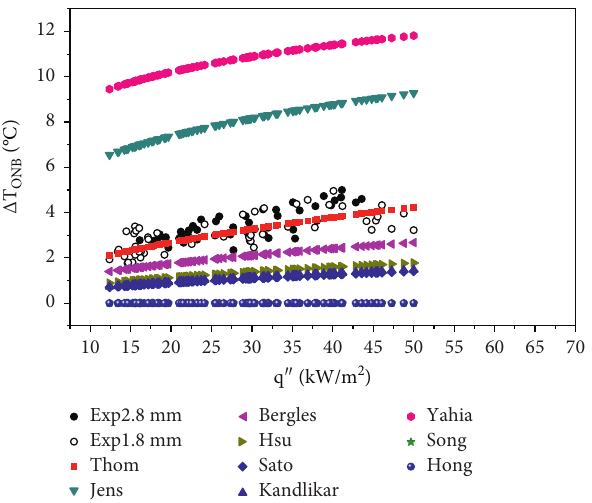
Figure 14: Comparison between experimental data and predicted values.